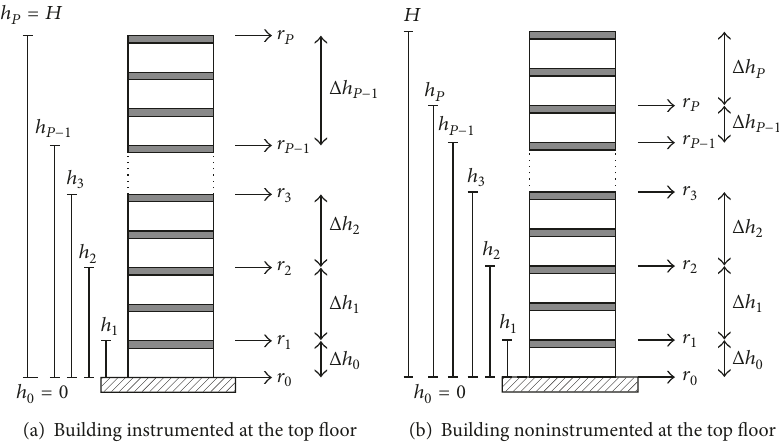
Figure 1: Building with height 𝐻 instrumented in 𝑃 floor